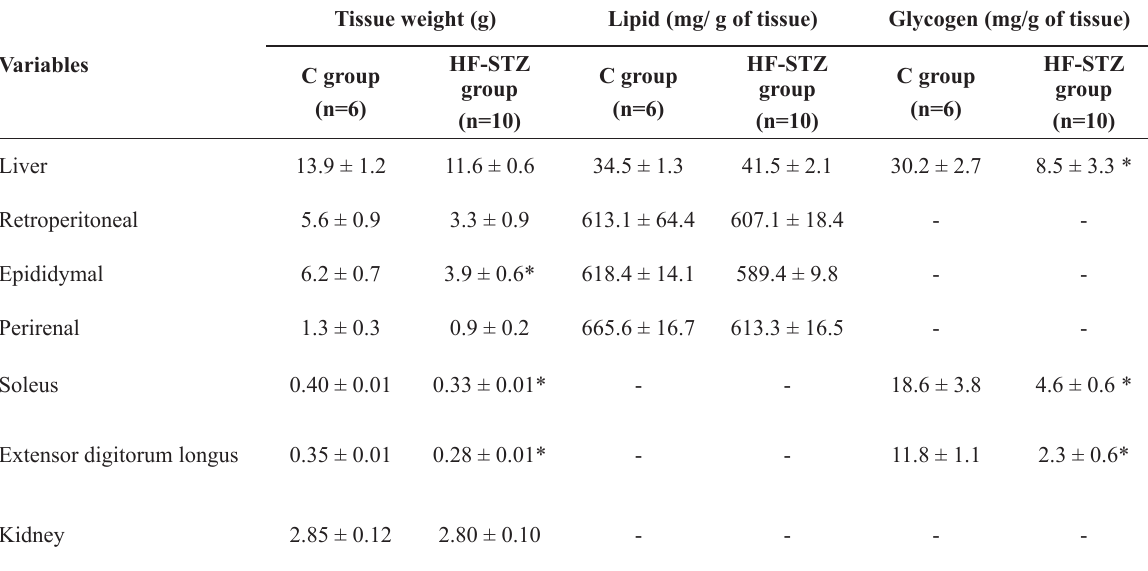
Tissue weight, lipid, and glycogen contents of male rats subjected to control diet (C) or high-fat diet/ streptozotocin